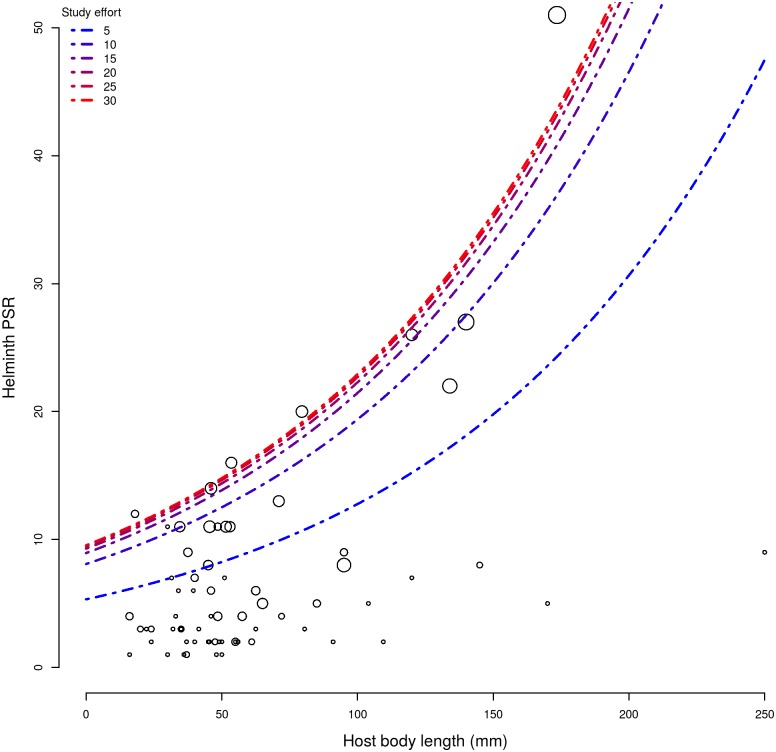
Estimates of helminth parasite species richness (PRS) to South American anurans of different body sizes in response to the number of studies (study effort).Each circle represents an anuran species, the size of each circle shows the real study effort, dashed lines show the estimated PRS in response to different study effort.